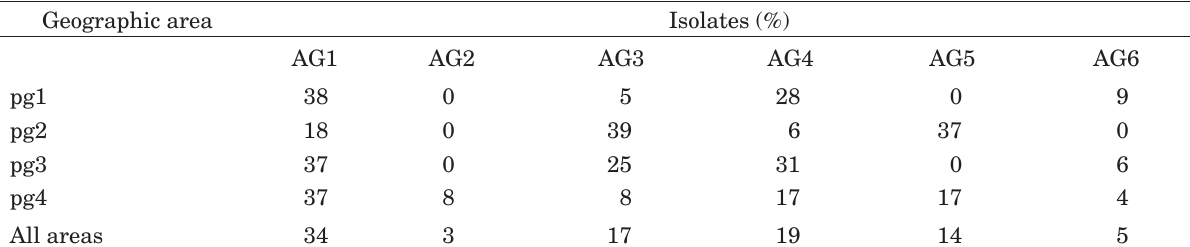
Table 2. Percentage of Mycosphaerella pinodes isolates of each aggressiveness group in the four geographic areas determined by hierarchical classification (HCA) analysis.